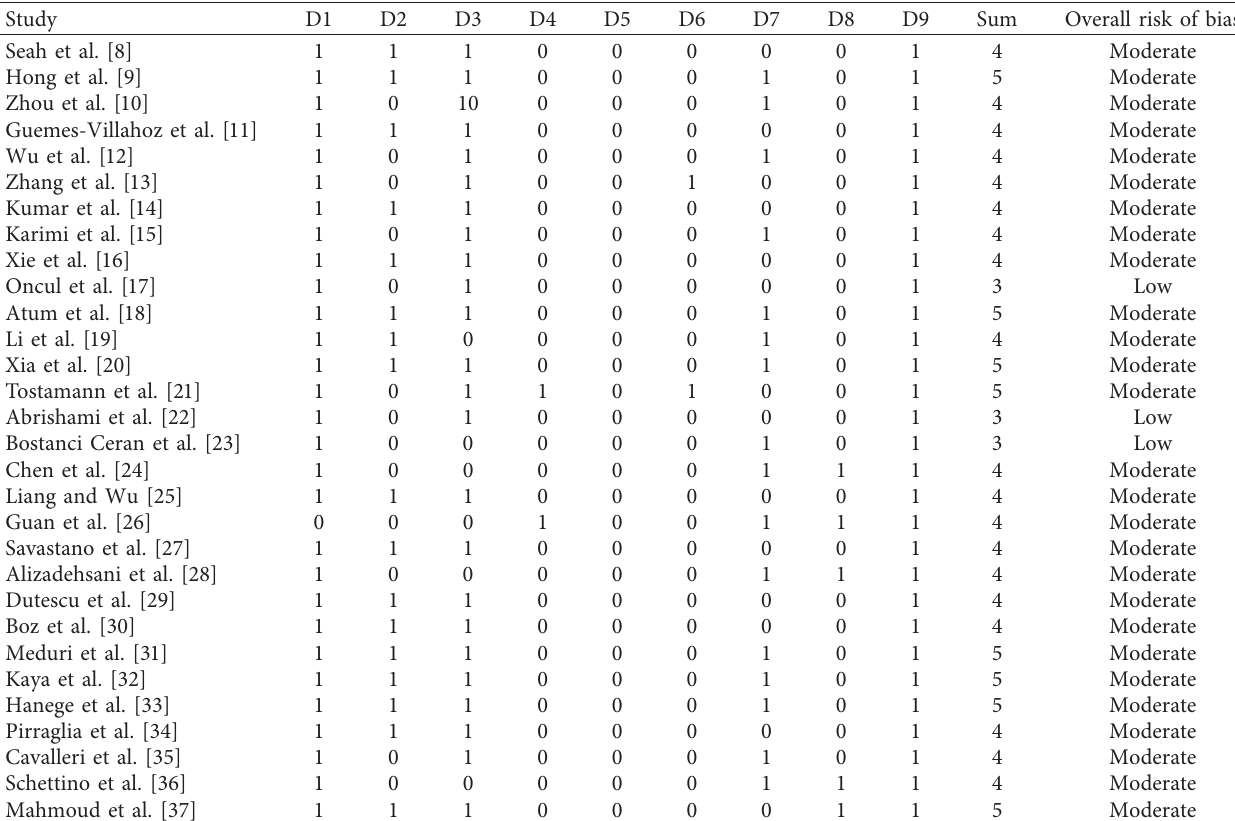
Figure 1: Preferred reporting items for systematic reviews and meta-analyses (PRISMA) flow diagram for the searching and identification of included studies. Table 1: Risk of bias for individual studies included in the